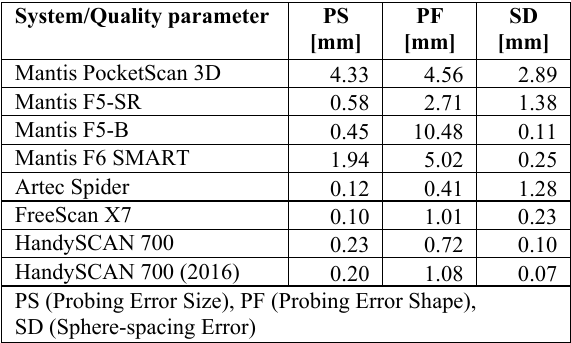
Table 2. Quality parameter according to VDI/VDE 2634, part 2 and